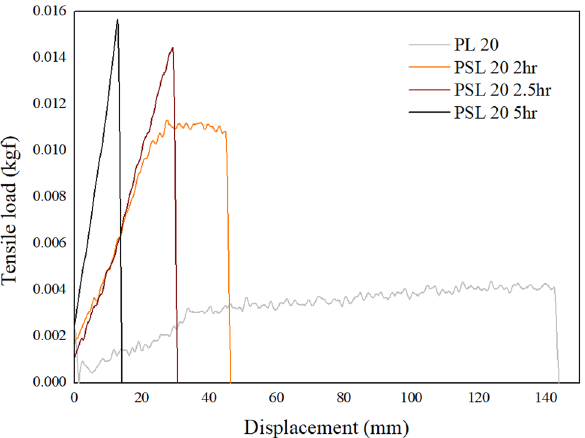
Figure 6. Representative load–displacement curves of the LLDPE fiber (Melt flow index 20) and sulfonated LLDPE fiber (Melt flow index 20) with various sulfonation time under a pressure of 5 bar and temperature of 130